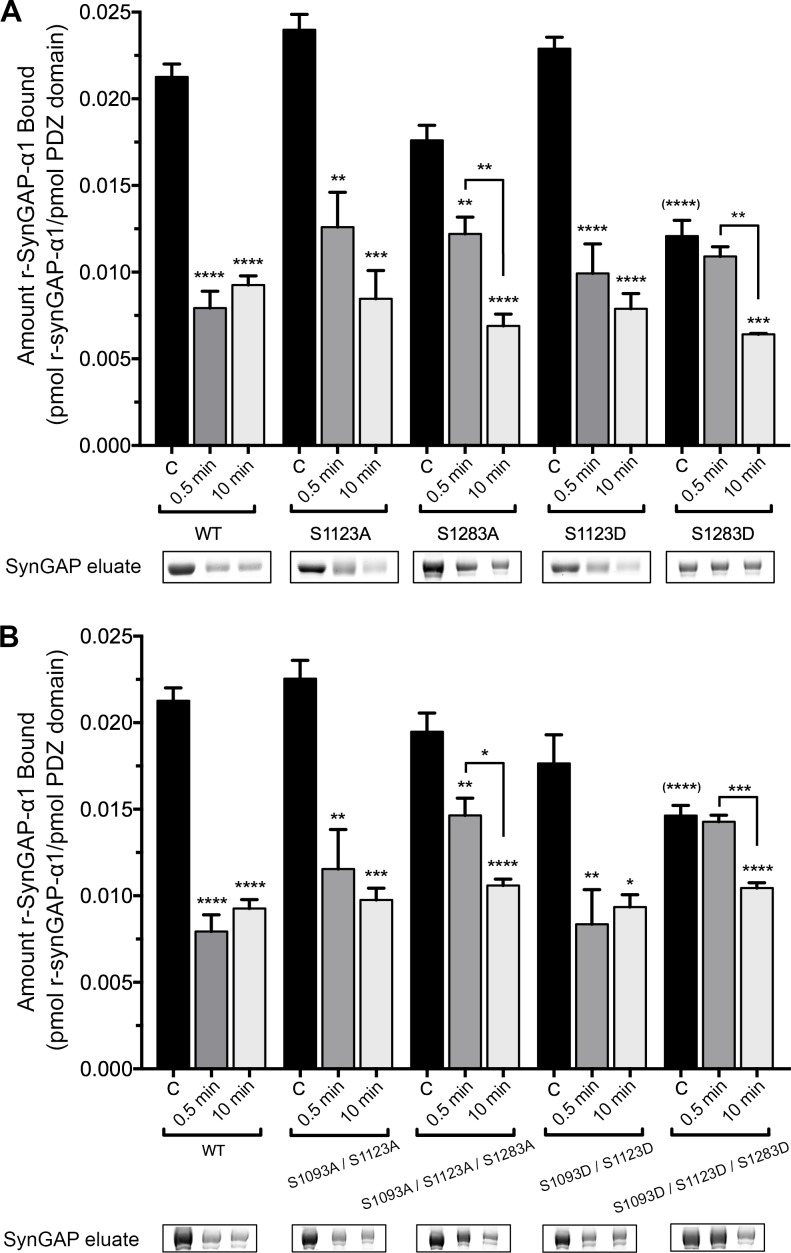
Effect of phosphorylation by CaMKII on association of PDZ123 domains with phospho-deficient and phospho-mimetic mutants of r-synGAP-α1.Wild-type and mutant r-synGAP-α1 were incubated with phosphorylation mixtures for 10 min without (Control), or for 0.5 or 10 min with 10 nM CaMKII, 0.7 mM CaCl2/3.4 μM CaM(CaMKII), then incubated with PDZ123 affinity resin for 60 min at 25°C, as described under 'Materials and methods.' (A) Binding to PDZ123 of r-synGAP-α1 and single mutations at S1123 and S1283. Sites S1123 or S1283 were mutated either to alanine (S1123A, S1283A) or to the phosphomimetic aspartate (S1123D, S1283D). (B) Binding to PDZ123 of r-synGAP-α1 and double or triple mutations at S1093, S1123, and S1283, as indicated. Data are mean ± S.E. (n = 4). The statistical significances of differences between wild type and the various mutants in binding to PDZ123 before phosphorylation were determined by ordinary one way ANOVA (Tukey correction for multiple comparisons). Only mutations including S1283D were significantly different from wild type (indicated by (****)). Differences between unphosphorylated and phosphorylated individual mutants were compared individually by ordinary one way ANOVA (uncorrected Fisher’s LSD). *pp<0.05; **p<0.01; ***p<0.005; ****p<0.0001. See the text for additional statistical comparisons.